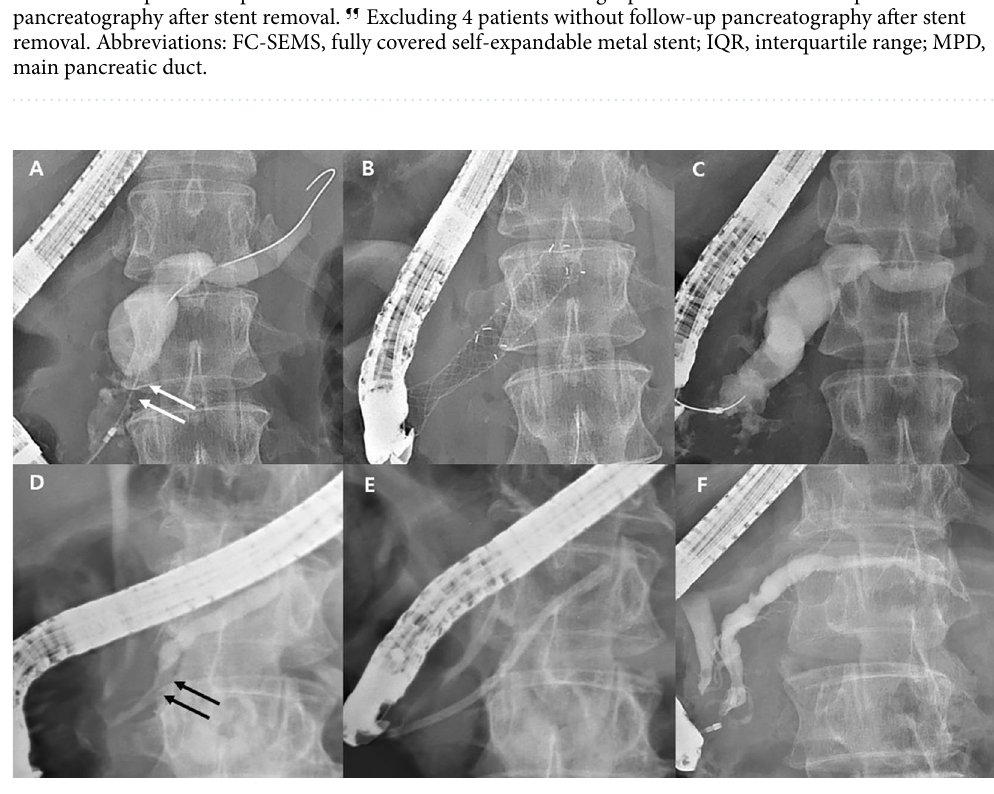
Figure 1. Fluoroscopic images of endoscopic retrograde pancreatography. Pancreatography shows a pancreatic ductal stricture in the head (white arrows) with upstream duct dilatation ( a ). After 7 months of FC-SEMS placement ( b ), follow-up pancreatography reveals stricture resolution ( c ). Pancreatography shows a tight pancreatic duct stricture in the pancreas head (black arrows) with upstream duct dilatation ( d ). After 13 months of single plastic stent placement ( e ), follow-up pancreatography reveals stricture resolution ( f ). Abbreviation: FC-SEMS, fully covered self-expandable metal